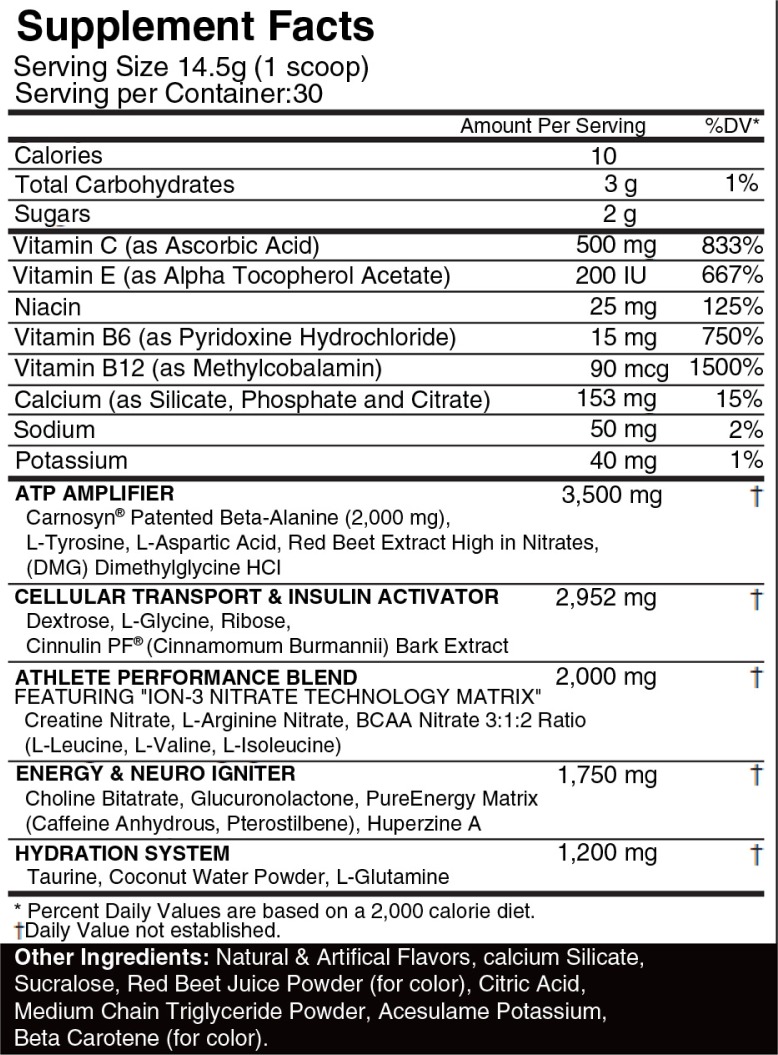
Supplement facts. Each serving contains beta-alanine, creatine, amino acids, caffeine, and approximately 700–800 mg of dietary nitrate.